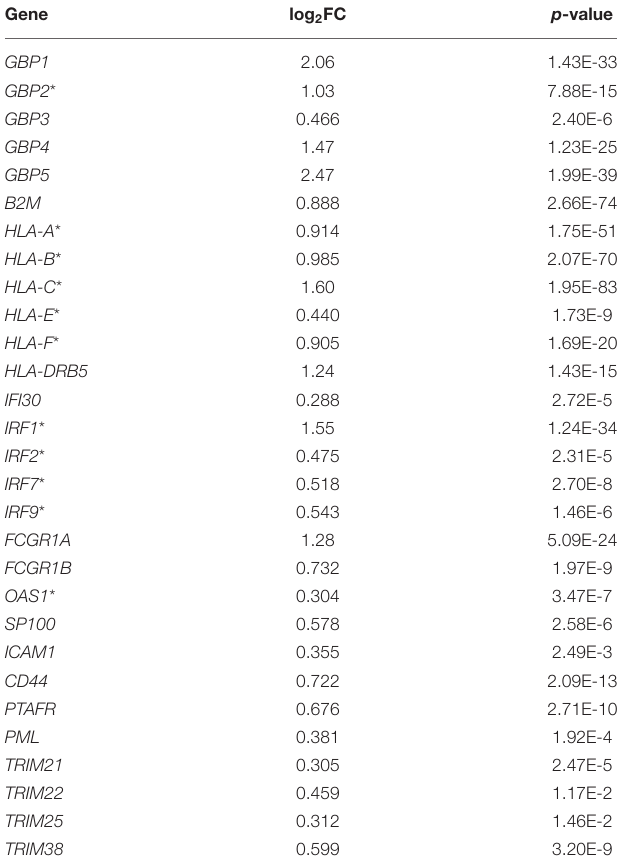
TABLE 2 | Interferon- γ stimulated genes are upregulated in monocytes/macrophages from HS lesions compared to healthy skin.